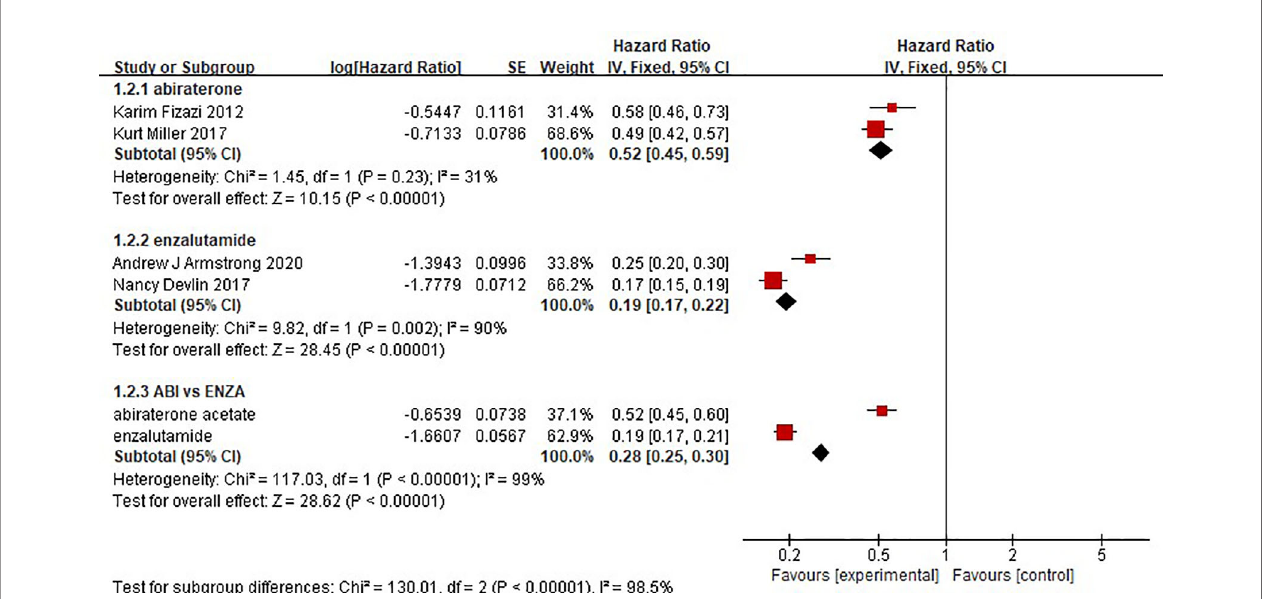
FIGURE 5 | Forest plots for time to prostate-speci fi c antigen progression in